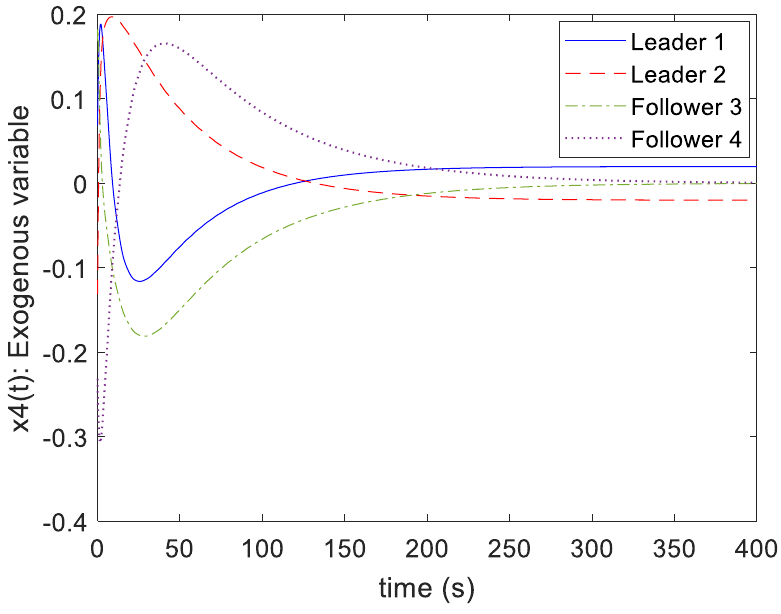
  x t with IT-2 fuzzy control. 3